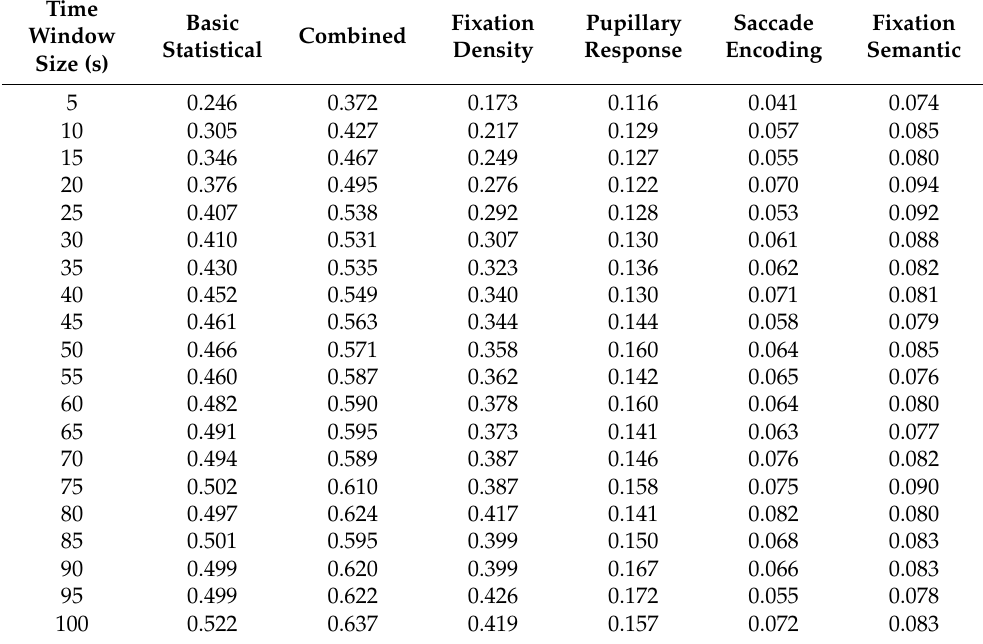
Table A2. Mean accuracy of the LORO identification